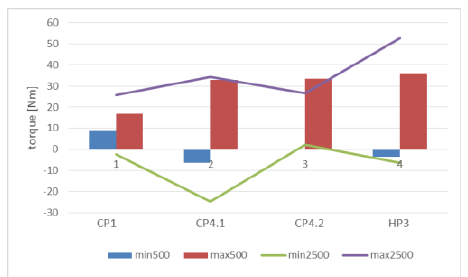
Fig.11. Minimum and maximum torque at 140 MPa pumping pressure and 500 and 2500 rpm shaft